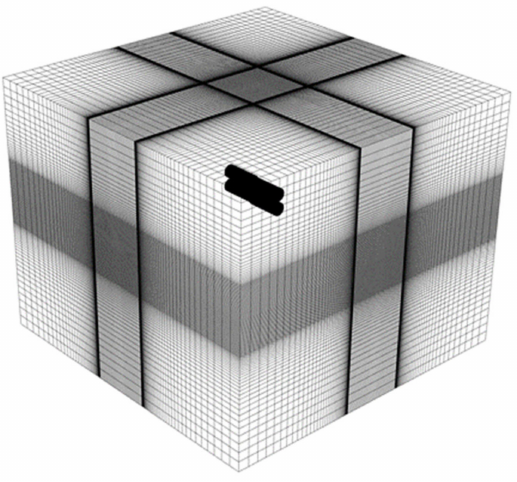
Figure 3. Coaxial dual-rotor structure motion nested grid